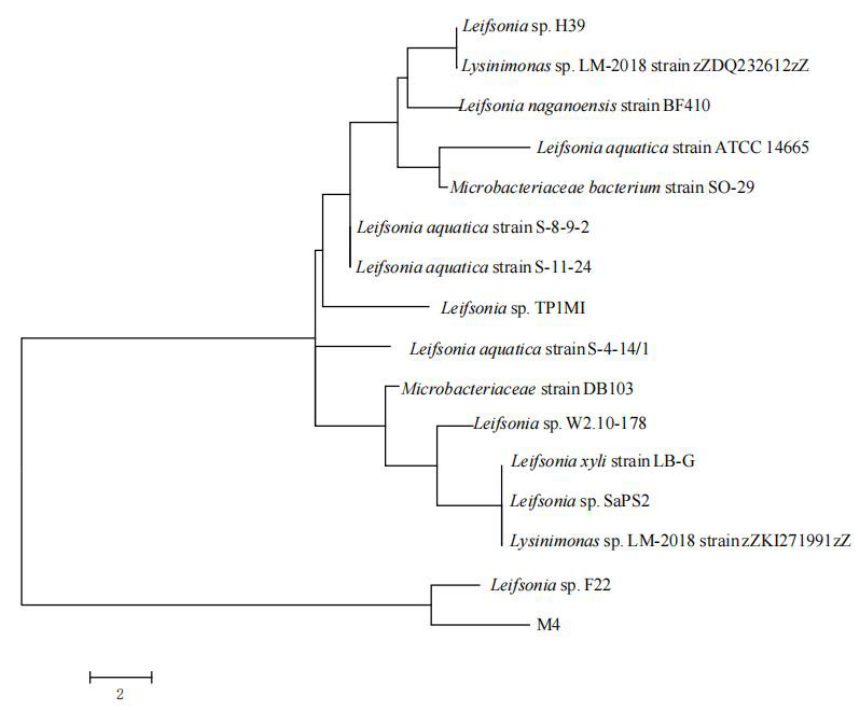
Figure 2. The phylogenetic tree constructed using a neighbor-joining method based on 16S rDNA gene sequence numbers at the nodes indicate the bootstrap values on neighbor-joining analysis.